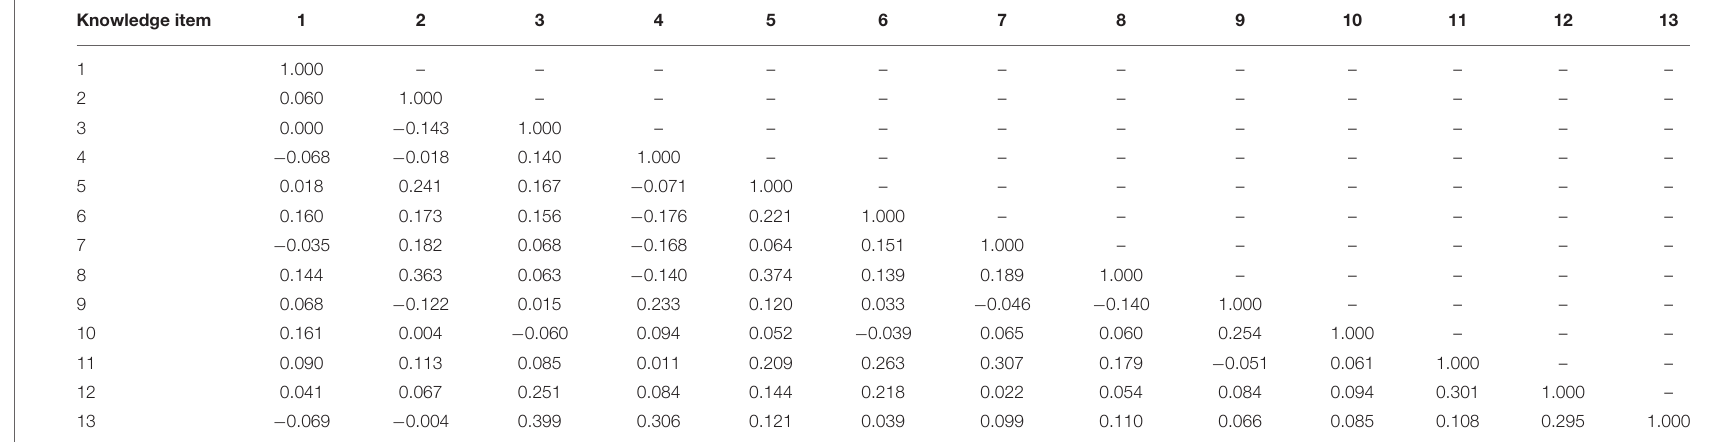
TABLE 5 | Inter-item correlation coefficients for Indonesian adolescents mental health knowledge questionnaire.